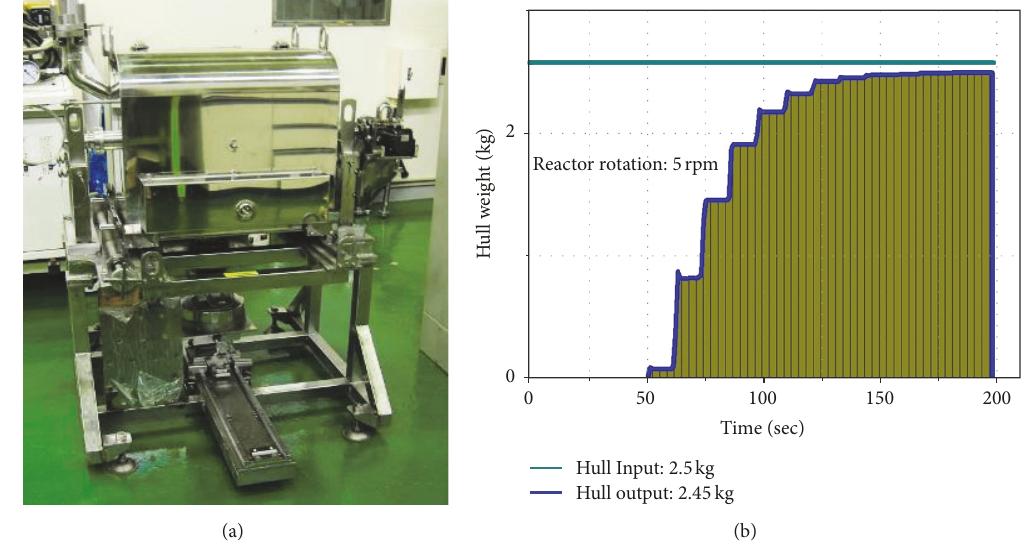
Figure 3: Hull-separation testing of the prototype device: (a) prototype; (b) separation results.